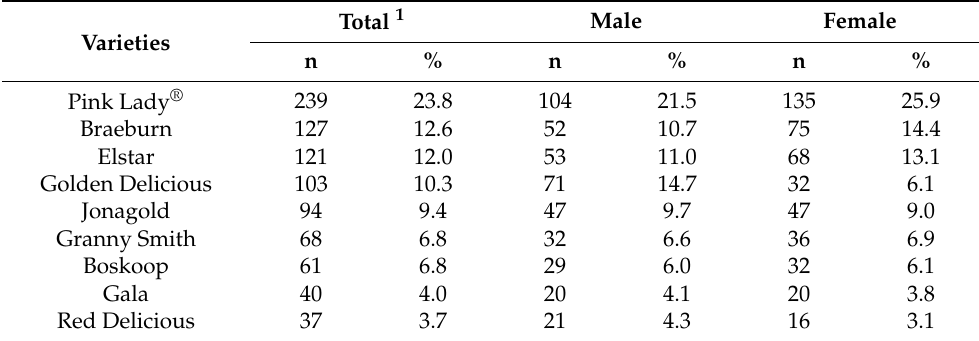
Table 3. Most often purchased apple varieties of German consumers by